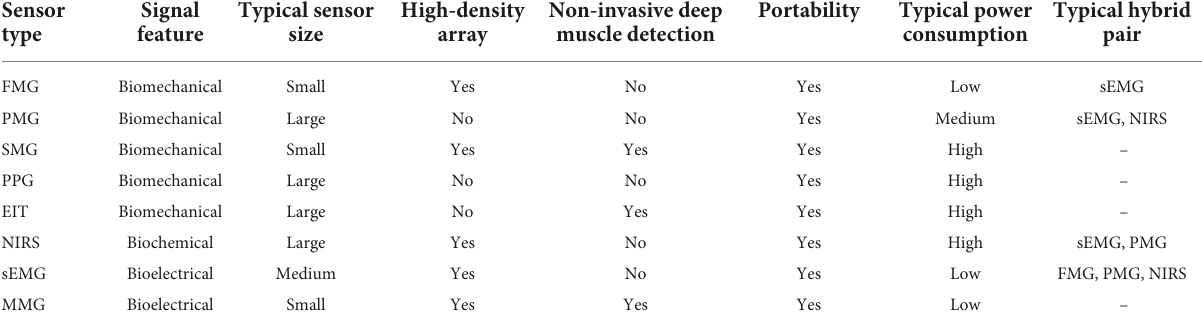
TABLE 2 General comparison between myography sensing